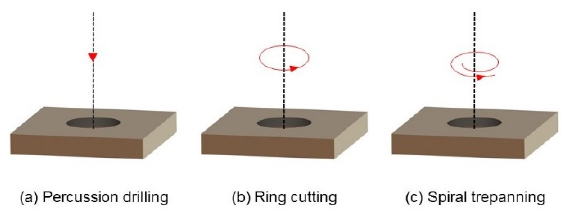
Figure 1. Di ff erent laser processing Figure 1. Different laser processing methods.